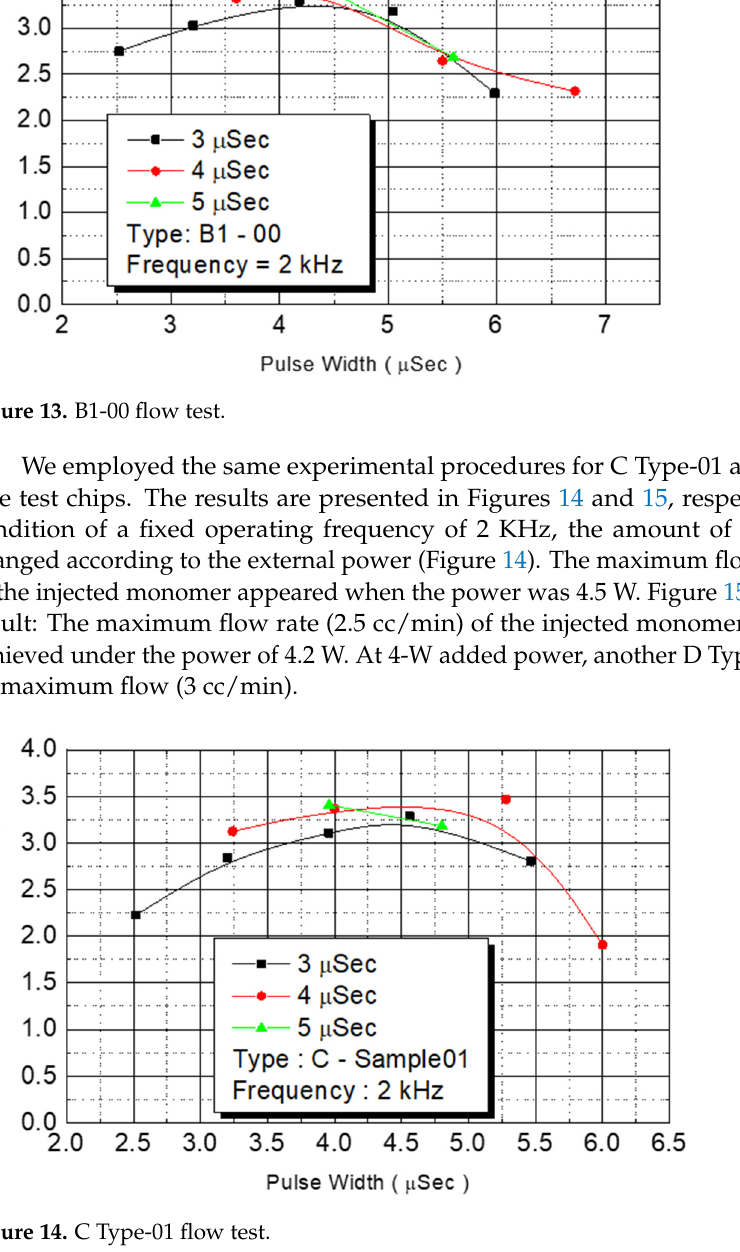
Figure 14. C Type-01 flow test.